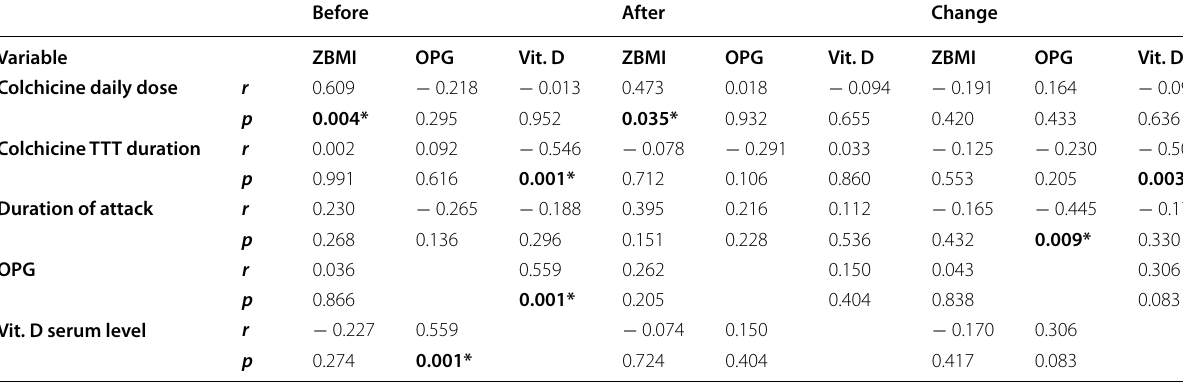
Total 33. ZBMI , body mass index Z scores, TTT treatment, OPG osteoprotogerin, r correlation coefficient, p < 0.05 is a significant correlation. Pearson correlation. = *Significant